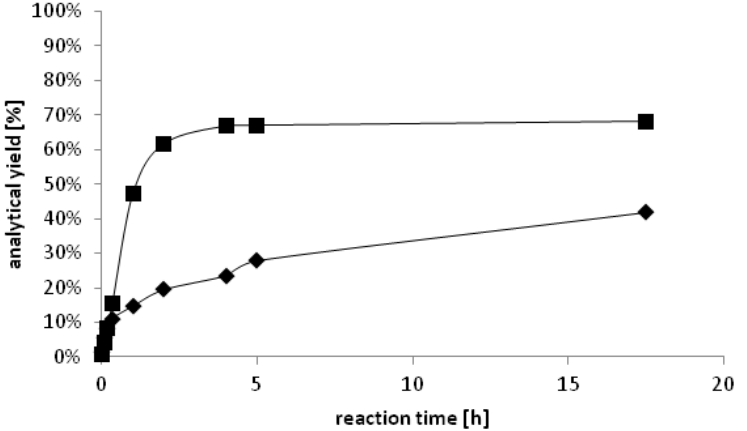
Figure 3. Time dependent formation of  ( S )-2-octanol (<99% ee ) catalyzed by Yl ADH2 and ■ ( R )-2-octanol (<99% ee ) catalyzed by Yl